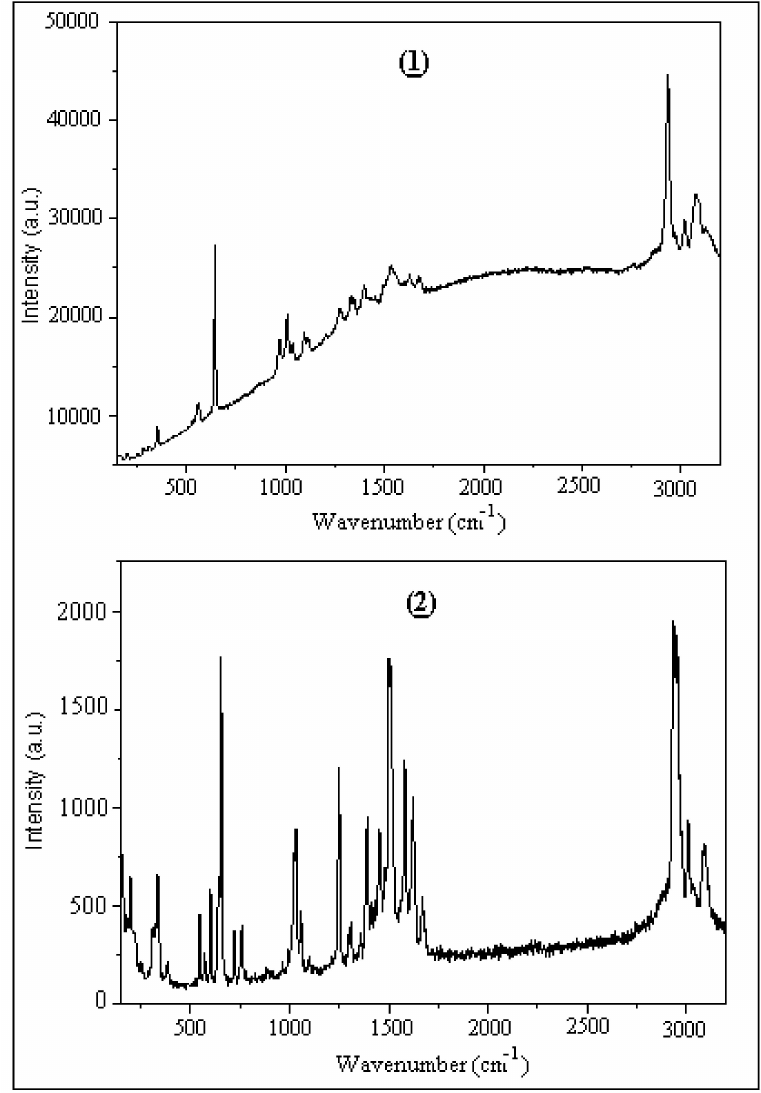
Figure 16. Experimental Raman spectra of ( 1 ) and ( 2